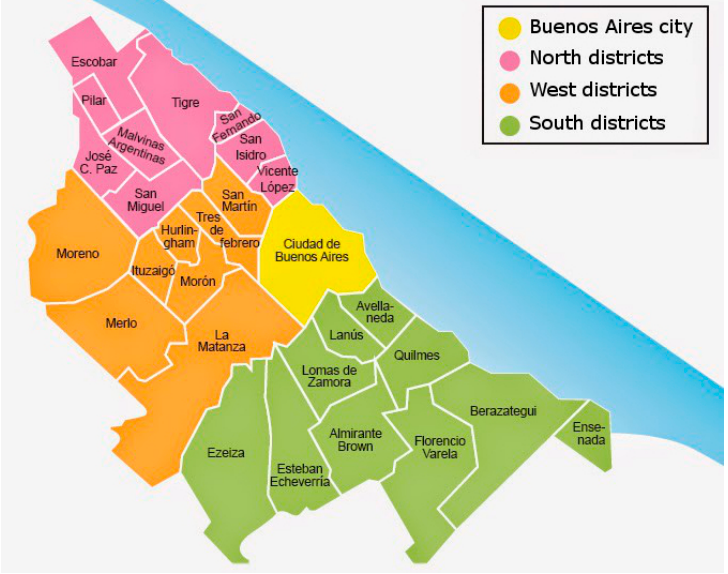
Figure 2. Gran Buenos Aires